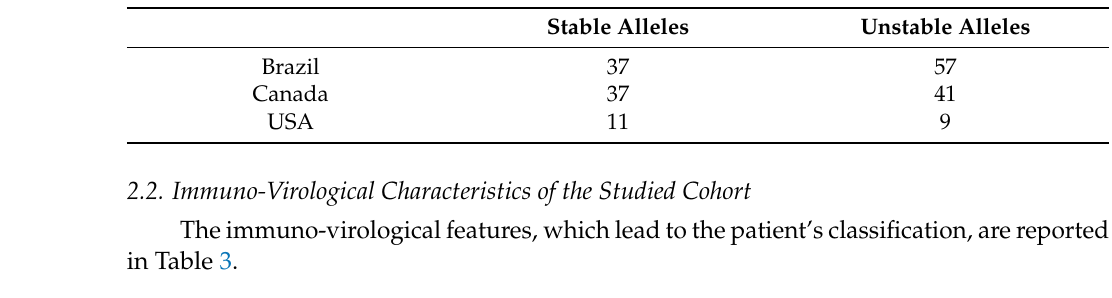
Table 3. Immuno-virological characteristics of the studied